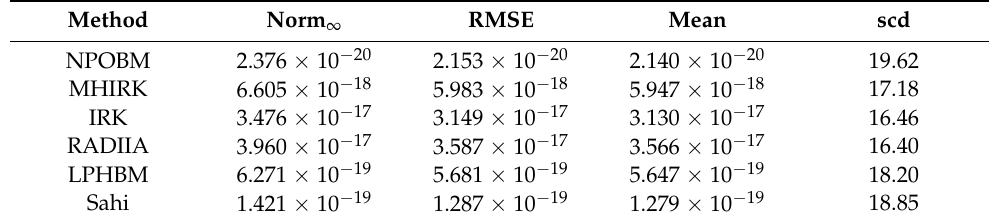
Table 7. Numerical results for Problem 2 with NS = 2 8 where x ∈ [ 0,5 ]